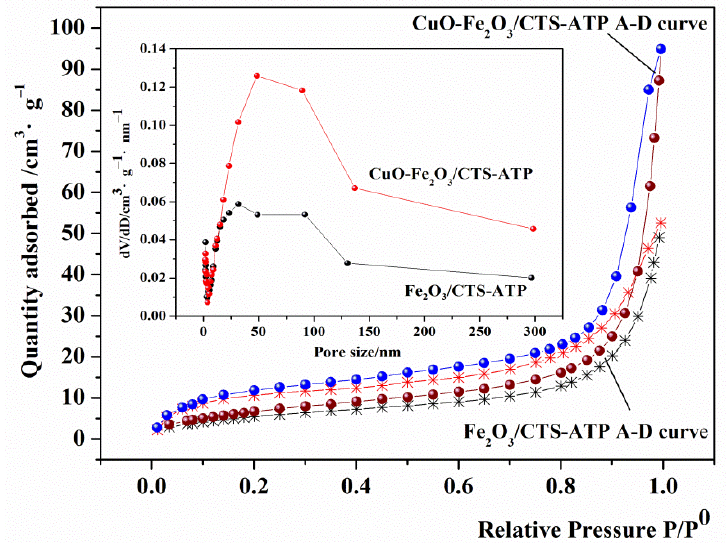
Figure 3. Nitrogen adsorption – desorption curves and pore size distribution diagrams of Fe 2 O 3 /CTS- ATP and CuO-Fe 2 O 3 /CTS-ATP.